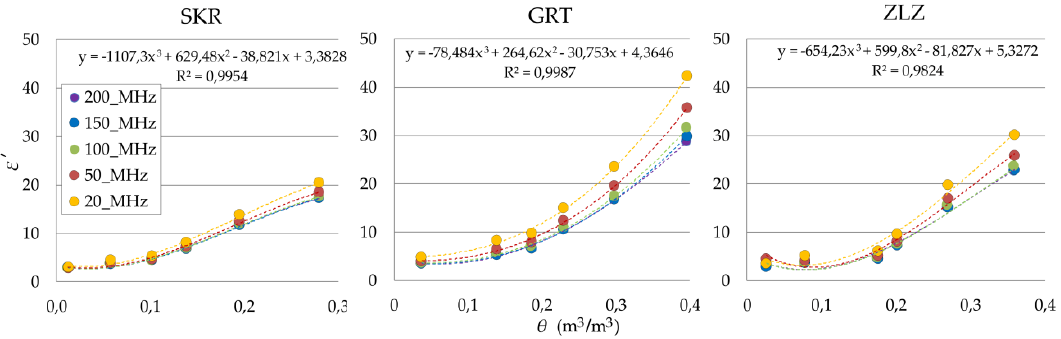
Figure 7. Relation between θ and ε (cid:48) of the tested soils (SKR, GRT, ZLZ) at 20 MHz, 50 MHz, 100 MHz, 150 MHz and 200 MHz. Dashed lines represent third degree polynomials fitted to the data. Equations refer to data at 200 MHz.